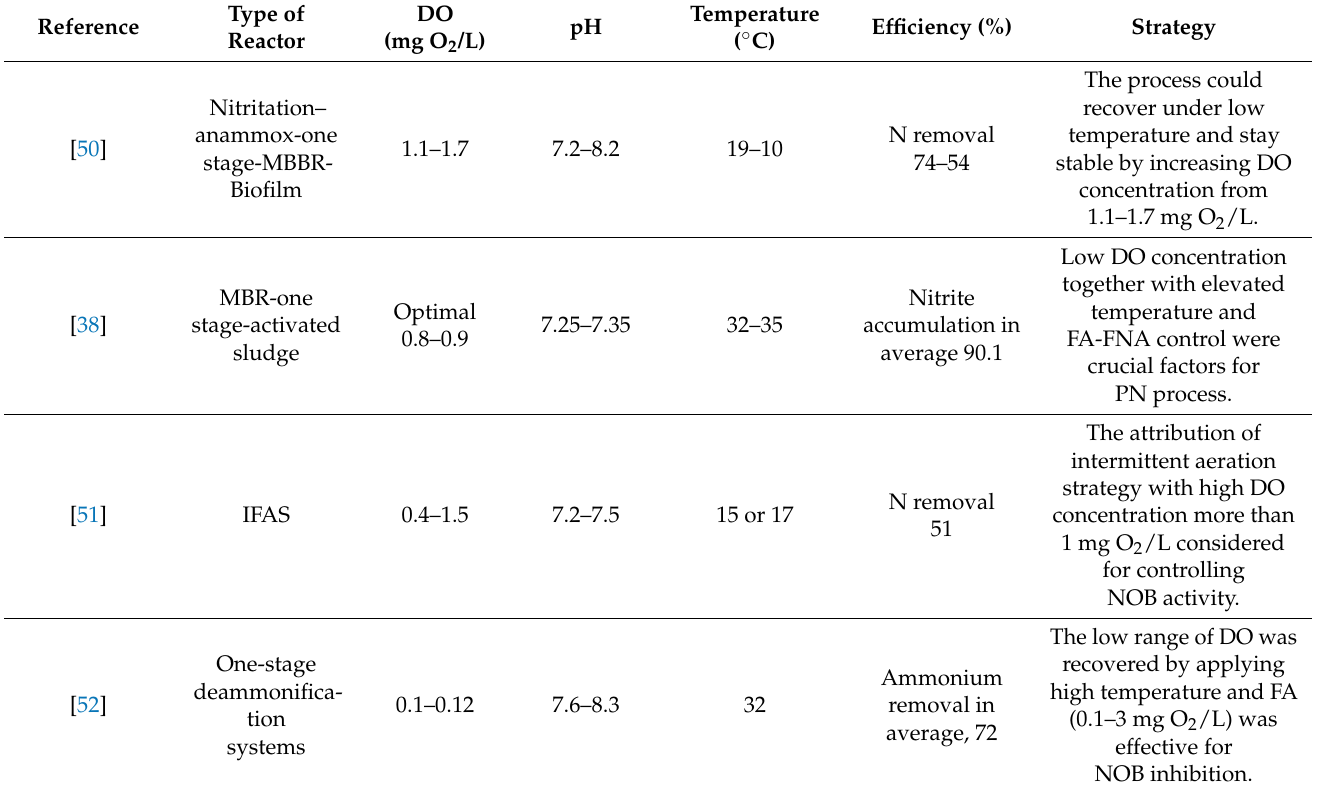
Table 3. The interaction between major operational factors and alternative